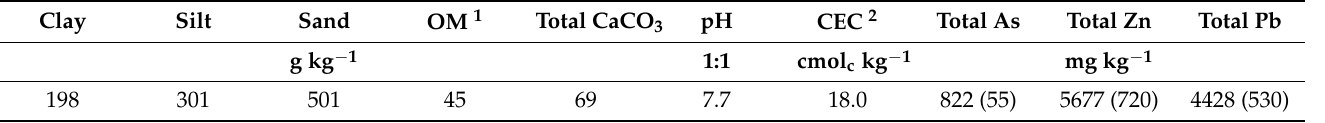
Table 1. Basic soil properties of the studied